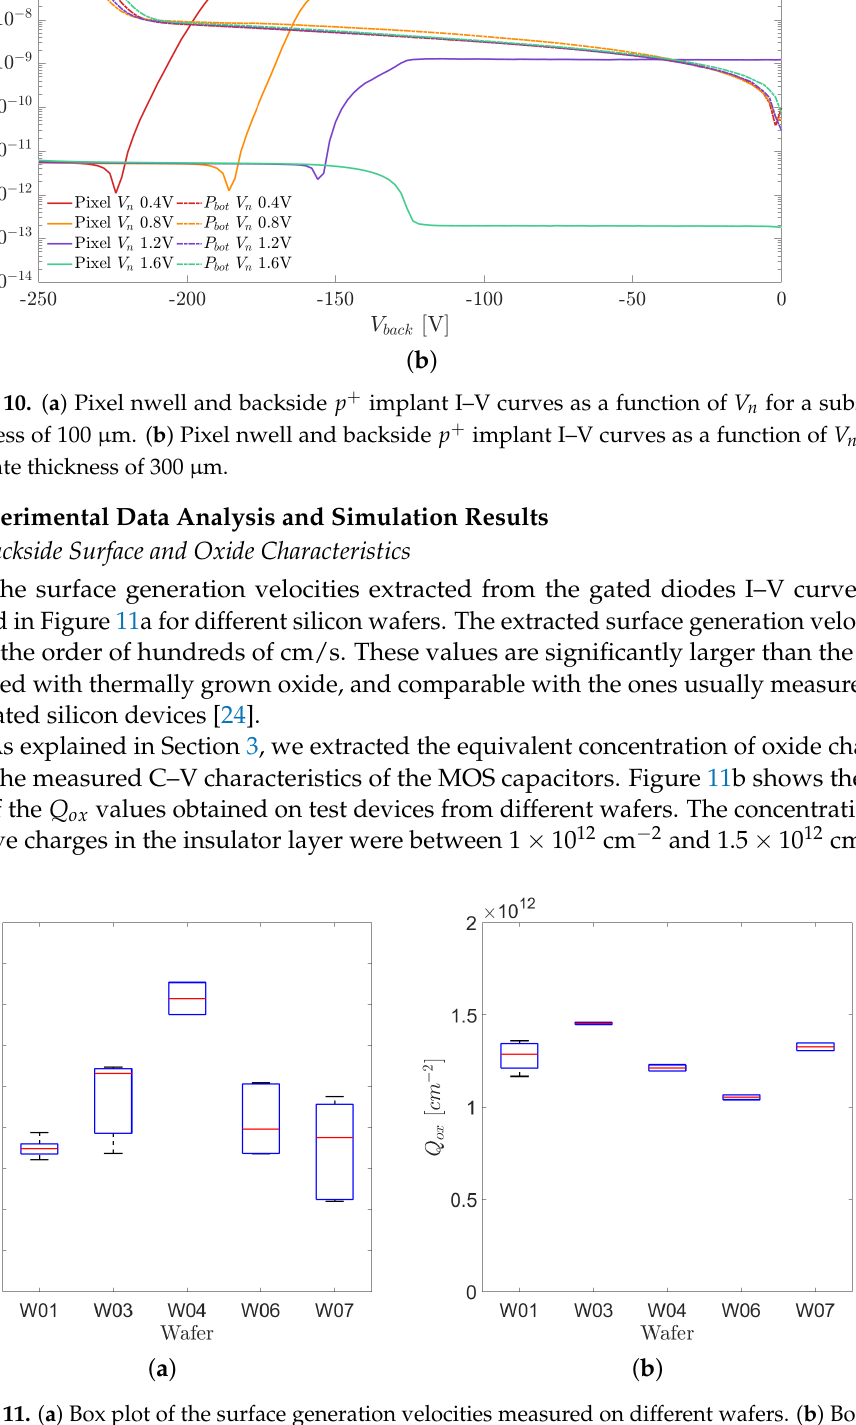
Figure 11. ( a ) Box plot of the surface generation velocities measured on different wafers. ( b ) Box plot of the concentration of charges in the surface passivation layer measured on different